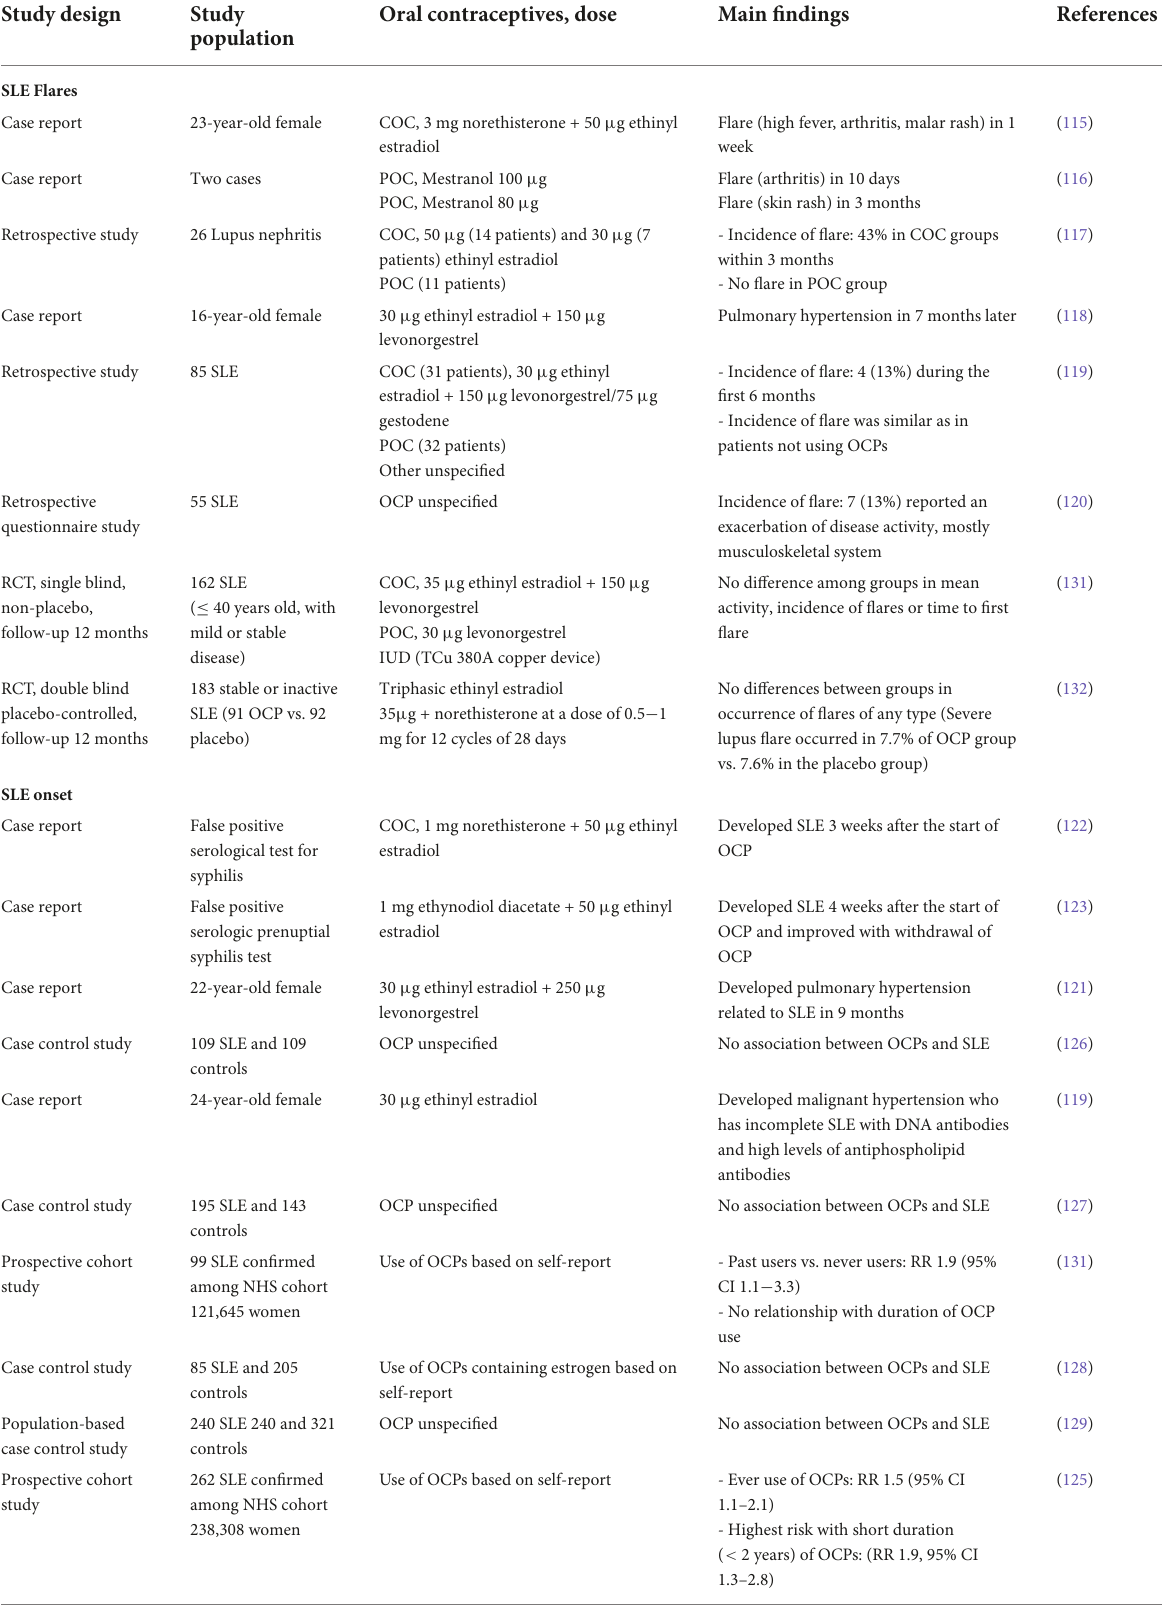
TABLE 1 List of studies on the risk of disease onset or flares in patients with systemic lupus erythematosus using oral contraceptives. Study